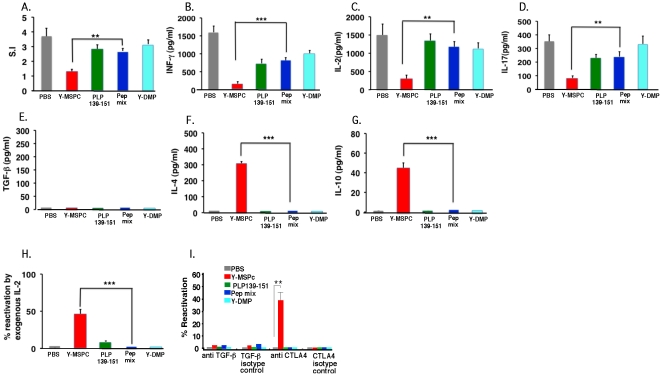
Systemic administration of Y-MSPc induces longer lasting peripheral regulatory mechanisms than PLP139-151 peptide or peptide mixture (huPEP mix).(C57Bl.FoxP3GFPxSJL/J)F1 mice were immunized with PLP139-151/CFA and injected i.v with YMSPc, PLP139-151, huPEP mix, Y-DMP, or with PBS, on day 3, 5, and 7 post immunization, as in Fig. 4. Seven days after last injection (14 days after immunization), splenocytes from each treatment group (n = 2/group) were pooled and analyzed as detailed for the LN cells in Fig. 4, for: (A), Ex vivo recall proliferative response to PLP139-151 (5 µg/ml); (B–G), Secretion of pro- and anti-inflammatory cytokines; (H, I), Ex-vivo recall proliferative response to PLP139-151 as in (A) but in the absence or presence of exogenous IL-2 (H), or neutralizing antibodies anti-TGF-ß or anti-CTLA-4 (I), or their respective isotype control antibodies. The ex-vivo analysis of the responses of splenocytes was carried out as detailed in the legend to Fig. 4, respectively. The data presented in A, H, and I, are the mean +/−SD values from three independent experiments. Data presented in B–G are the mean +/−SD of triplicate cultures of pooled splenocytes from one experiment representative of three independent experiments showing a similar pattern. The significance of the effect of Y-MSPc treatment compared to PBS control treatment was p = 0.002 in A; p = 0,0001 in B; p = 0.002 in C: p = 0.0009 in D: p<0.0001 in F: p = 0001 in G&H. The significance of the effect of Y-MSPc treatment compared to huPEP mix treatment: *, p<0.05; ** , p<0.005; ***, p<0.0005 (two tailed Student's t-test).